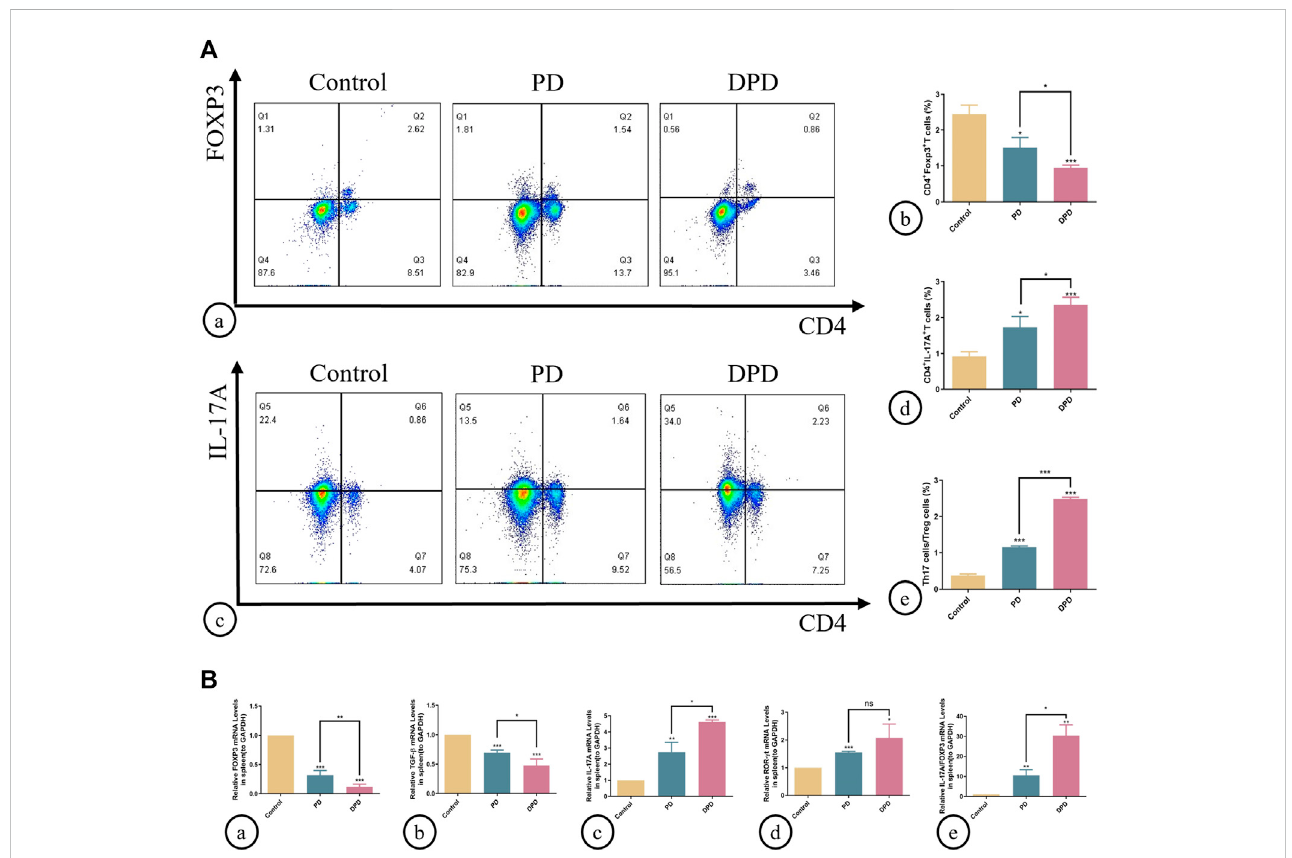
FIGURE 2 Flowcytometryand qRT-PCRanalysisofTh17 andTreg cells inspleenlymphocytes. (A) (A) Flow cytometry analysis ofCD4 + FOXP3 + Tcells (intheupper rightquadrant)inthespleenlymphocytesinthecontrol,PDandDPDgroups.(b)StatisticalanalysisofCD4 + FOXP3 + Tcellsinthespleenlymphocytes.(c)Flow cytometry analysis of CD4 + IL-17A + T cells (in the upper right quadrant) in thespleenlymphocytes in thecontrol, PDand DPD groups. (d) Statistical analysis of CD4 + IL-17A + Tcellsinthespleenlymphocytes. (e)The ratioof Th17/Treg cells. (B) Relative mRNA expression level of (A) FOXP3, (b)TGF- β , (c)IL-17A, (d) ROR- ɣ t, and (e) the ratio of IL-17A/FOXP3 in the control, PD and DPD groups. Data were shown as mean ± SD (* p < 0.05. ** p < 0.01. *** p <